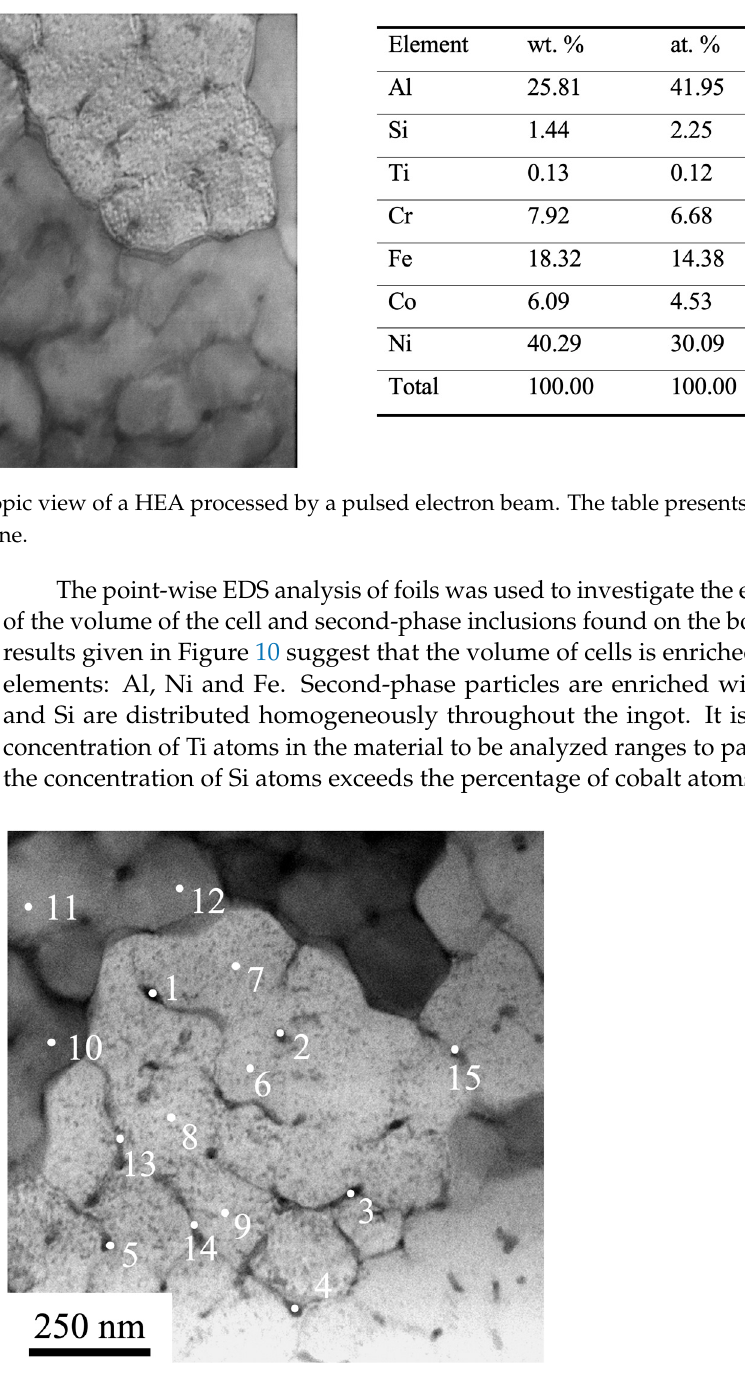
Table 4. The TEM-EDS elemental mapping outcomes (at. %) of the foil section presented in Figure 11.